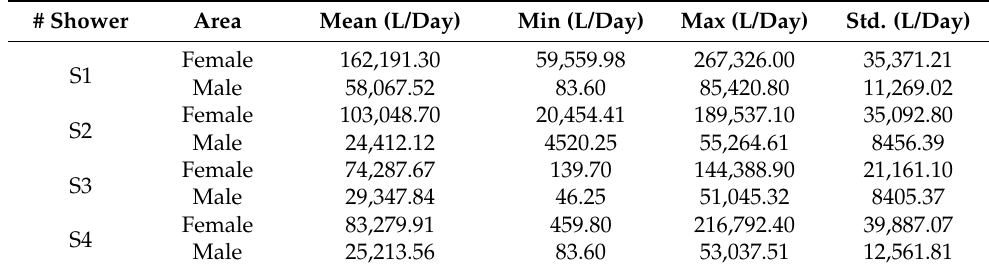
Table 1. Daily statistical information of the BWD data for shower areas.